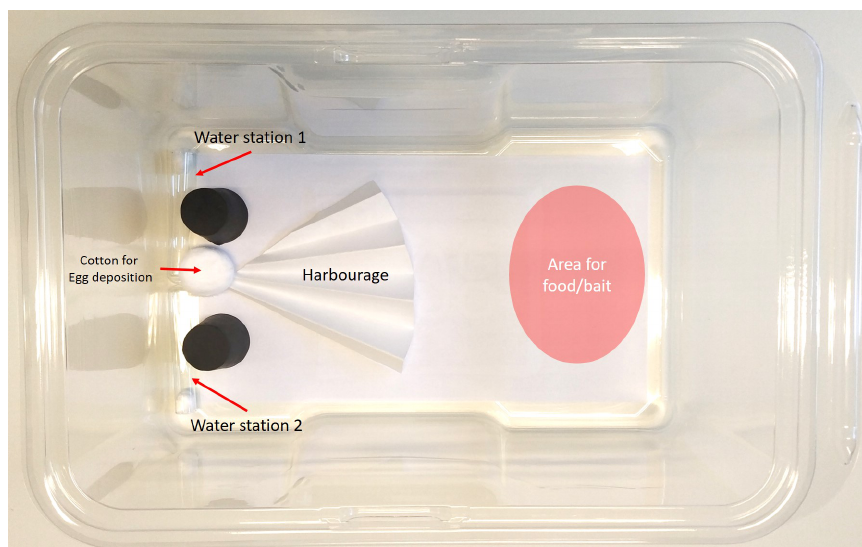
Figure 1. Arenas for bait testing with Ctenolepisma